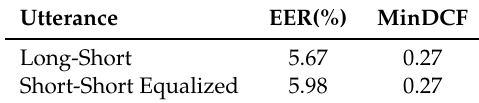
Table 4. Comparion of results, EER(%) and minDCF, for scenarios Long-Short Random and Short-Short with equalized results. SRE10 “coreext-coreext det5 female experiment”.